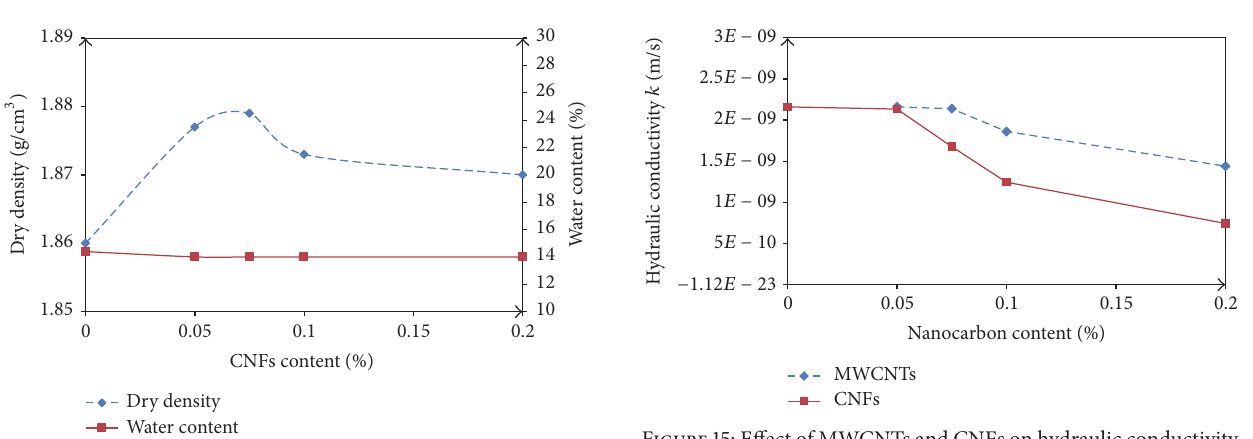
Figure 12: Effect of CNFs on the OMC and MDD.